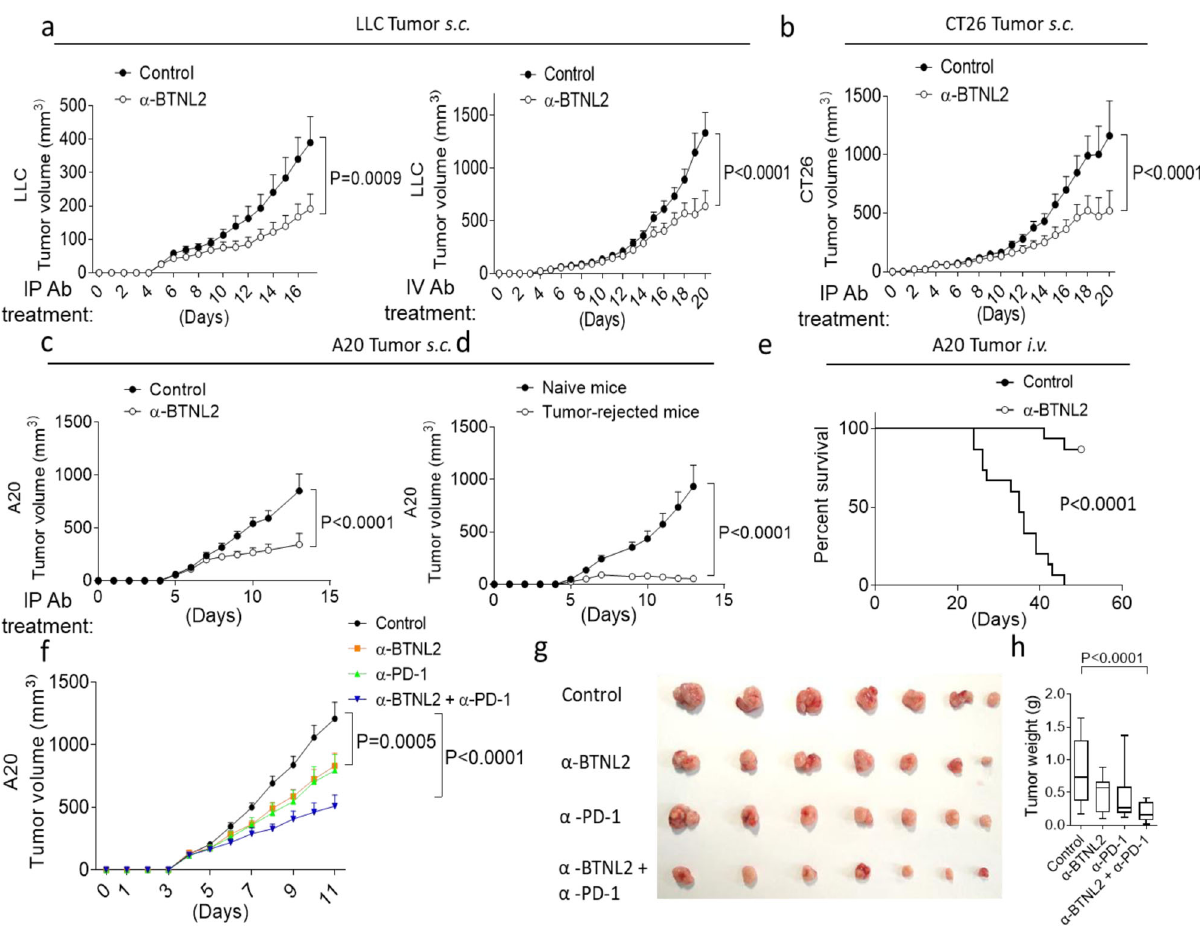
isotype rat IgG1 control Ab or anti-BTNL2 mAb (200 μ g/mouse) (left panel) or intravenous injected of antibody (200 μ g/mouse) (right panel) was